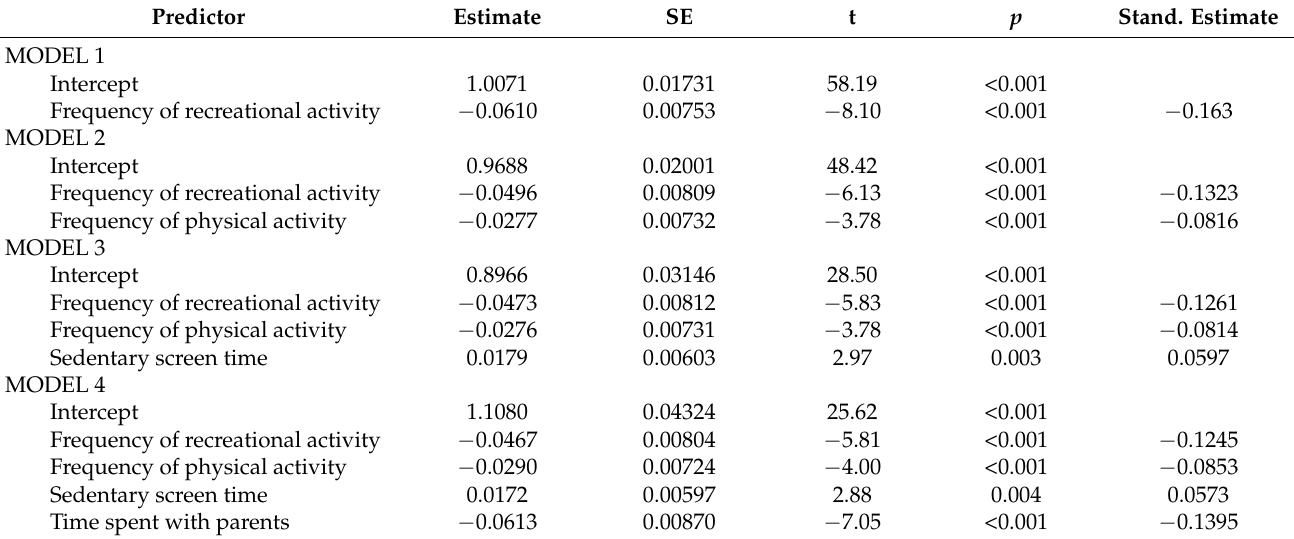
Table 3. Model coefficients resulting from multiple regression analysis.